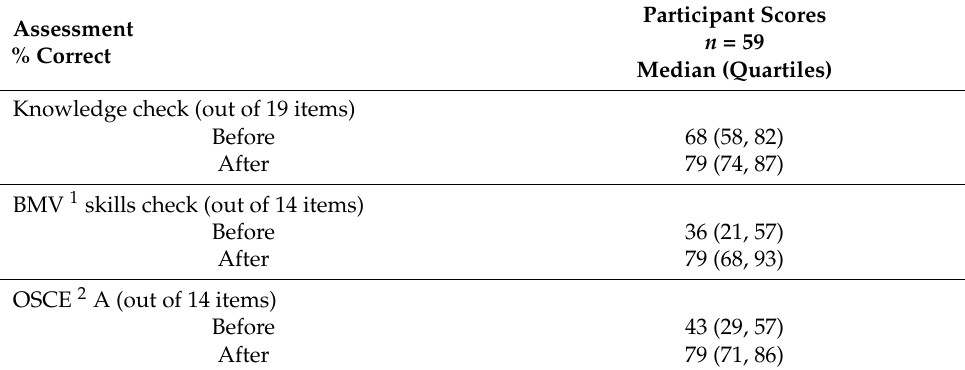
Figure 1. Event registration screen of the Liveborn app used for observational data collection. Figure 2. Liveborn neonates not breathing well at 30 s after birth from Facility A: breathing status from 30 s to 3 min after birth. Table 1. Provider knowledge and